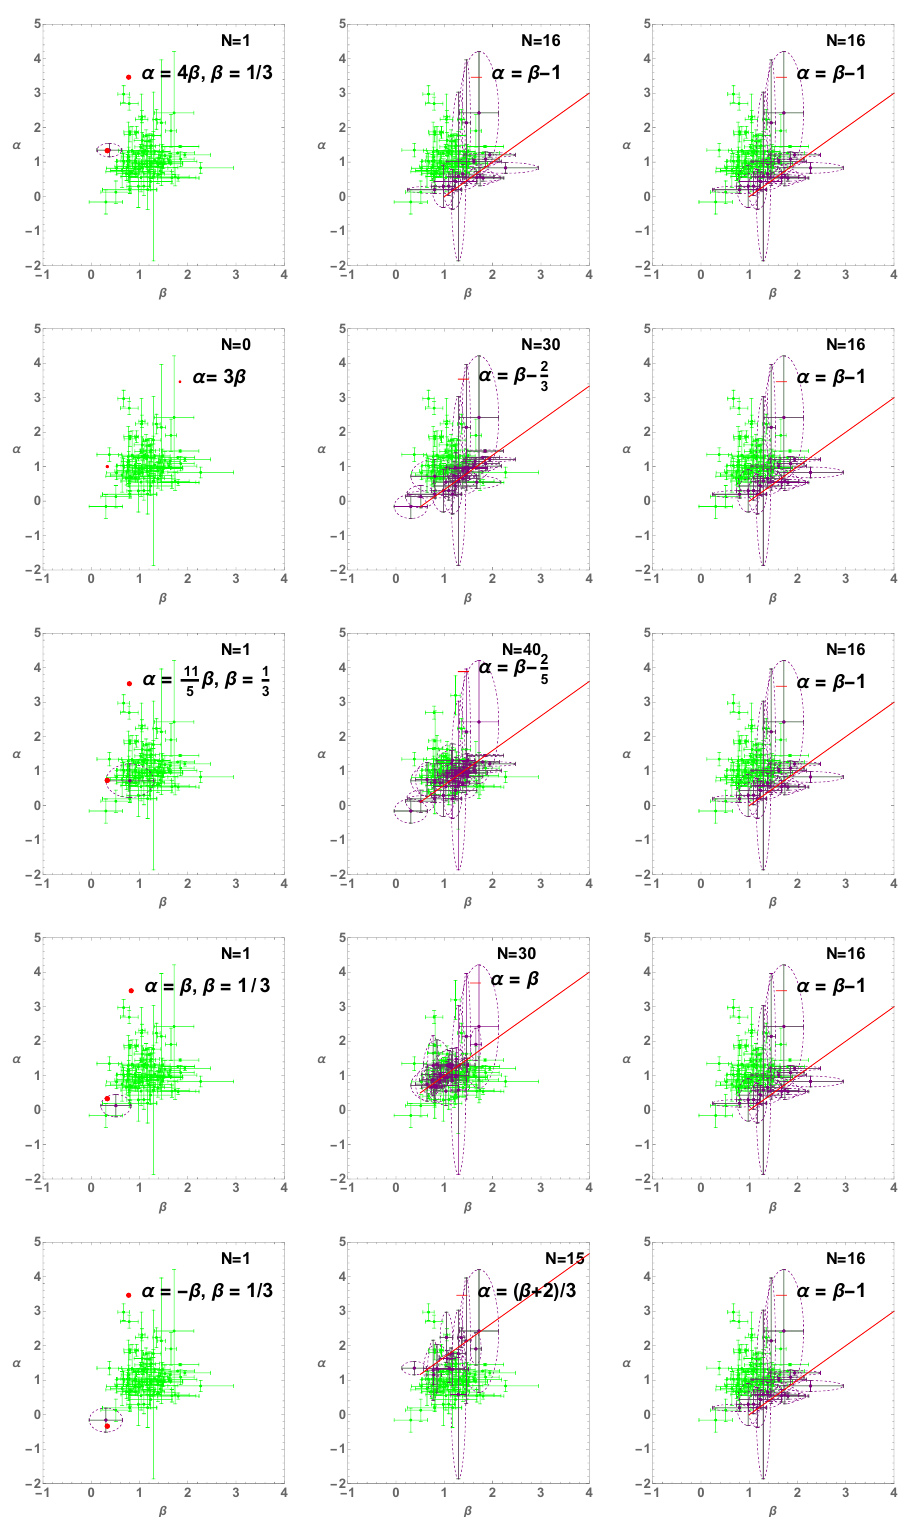
Figure 2. CRs from the FS model for k = 0,1,1.5,2, and 2.5 (top row to bottom row, respectively) without energy injection and q = 0 indicating energy injection. GRBs that satisfy the relations are shown in purple; other GRBs are shown in green. The first column shows the slow-cooling, ν m < ν < ν c regime, the second column shows the fast-cooling, ν c < ν < ν m regime, and the third column shows the ν > max{ ν c , ν m }